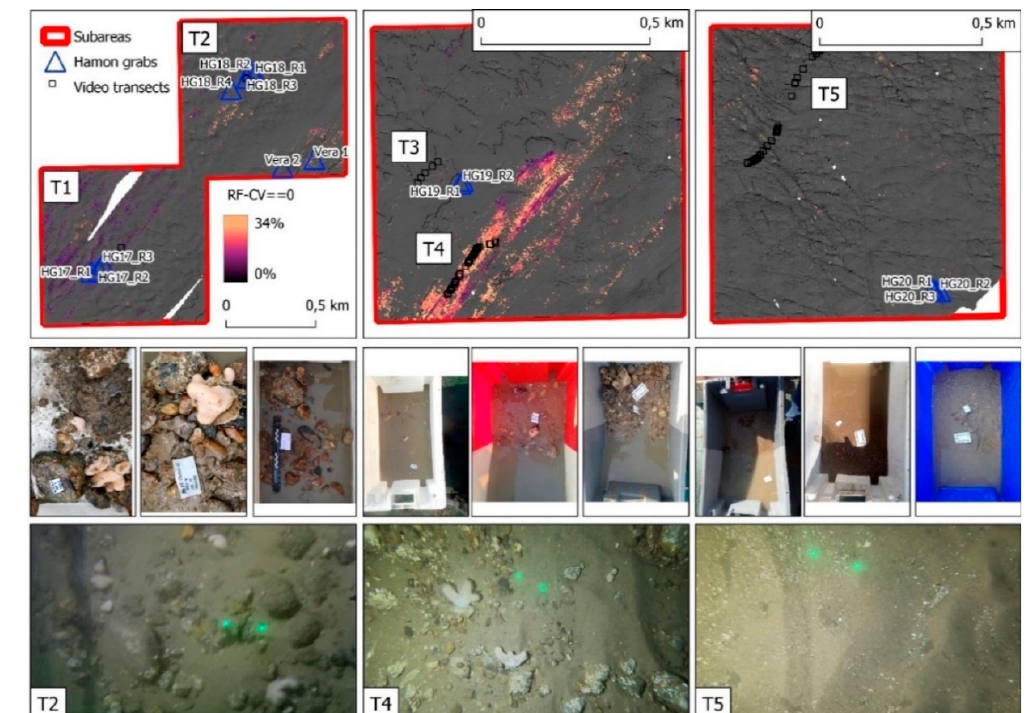
Figure 6. RF spatial predictions within the subareas selected for modelling. Locations shown in Figure 2. First row: predicted % areal cover of stones Ø ≥ 2 cm/m 2 (ISO 14688-1:2017 grain size classes) within quadrants I, II, III, and IV. The CBI is displayed beneath top and mid rows. BS: backscatter strength. Second row: coefficient of variation of the predictions. Third row: masked model predictions where the CV == 0, along with pictures of coincident Hamon grab samples and validation still frames from underwater videos (note video transect label for relative location on the maps). A semi-transparent hill shade layer is superimposed with 3 × vertical exaggeration for a prospective view of the surrounding geomorphology and the map colour palettes are displayed using quantile breaks. Fourth row: pictures of coincident Hamon grab samples. Fifth row: coincident underwater imagery. The laser points are 10 cm apart (frame randomly picked from 30% test dataset). Still frames T2 and T4 are from “dense stone lag shapes” whereas T5 is “bare sandy bottom”. Conspicuous epilithic species in the UI, noticeably colonies of A. digitatum and dense bioencrustations by S. triqueter.